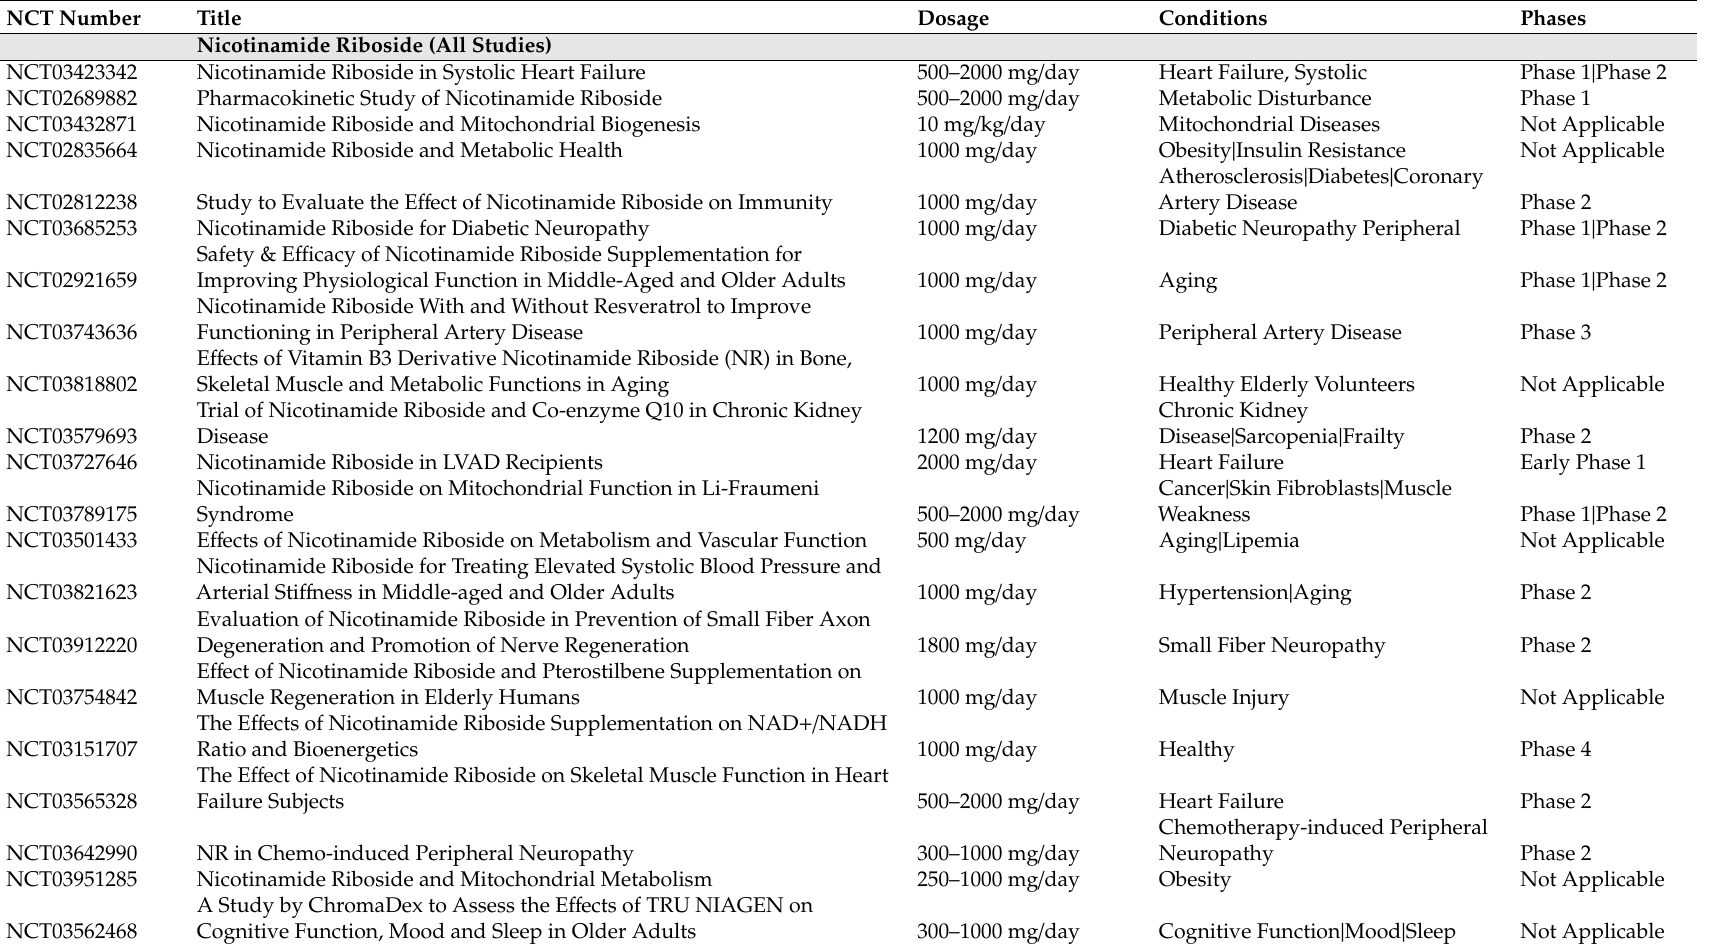
Table 1. The dosages of the Nicotinamide Riboside, l -serine, and l -carnitine used in previous human trials. The data retrieved from https: // clinicaltrials.gov. The dosage of the N -acetyl- l -cysteine is provided in Table